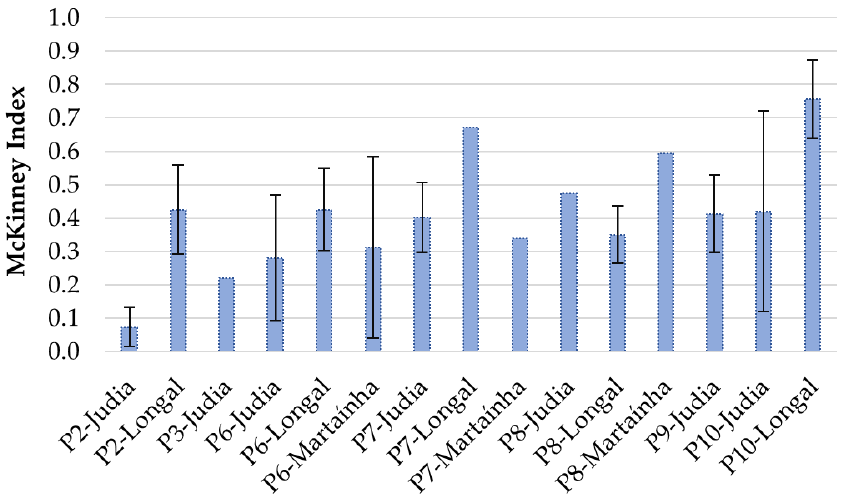
Figure 4. McKinney index for the infected (rot) chestnuts recorded at different processing stages for the varieties Longal, Judia and Martaínha.